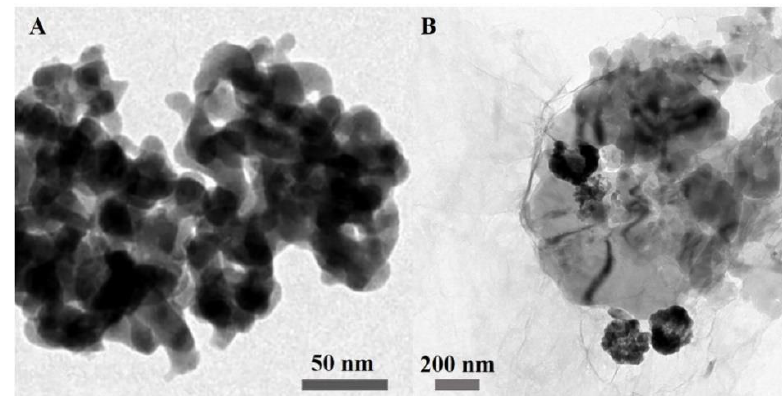
Figure 1. TEM images of TiO 2 nanoparticles (TiO 2 NPs) ( A ) and electro-reduced graphene oxide / ErGO) nanohybrids ( B nanohybrids (TiO 2 /ErGO) nanohybrids ( B ). nanohybrids (TiO 2